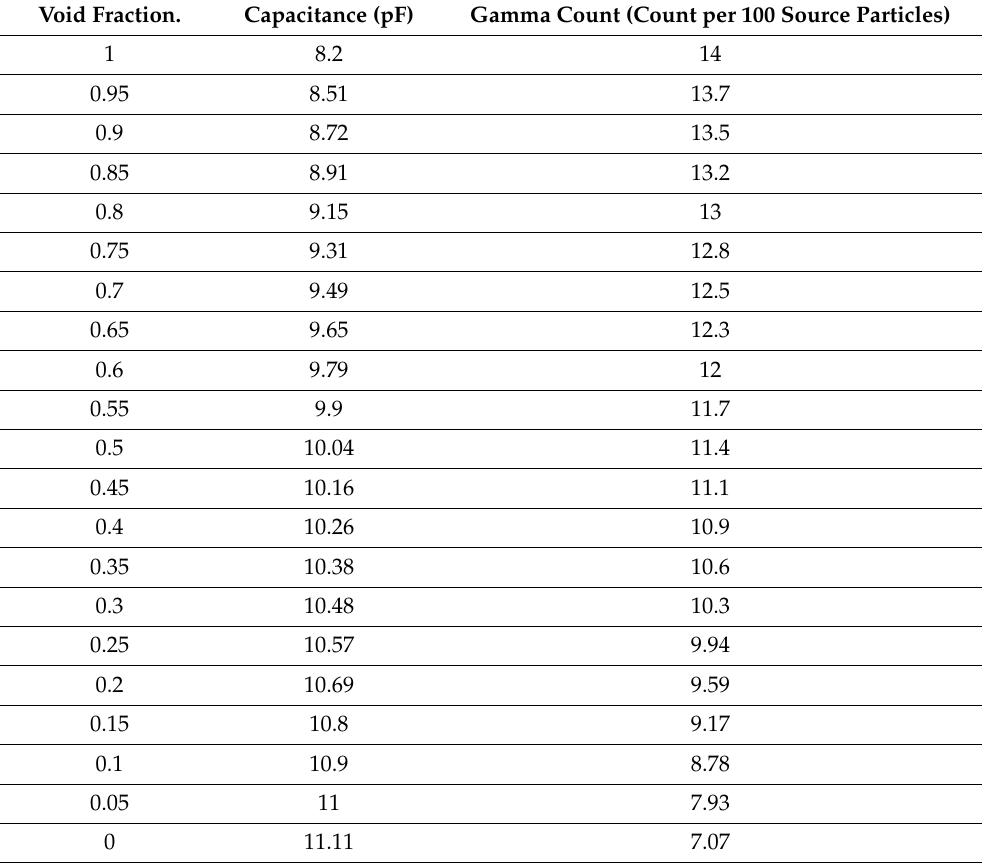
Table 1. Results of capacitance and gamma-ray attenuation-based sensors for void fractions. Void